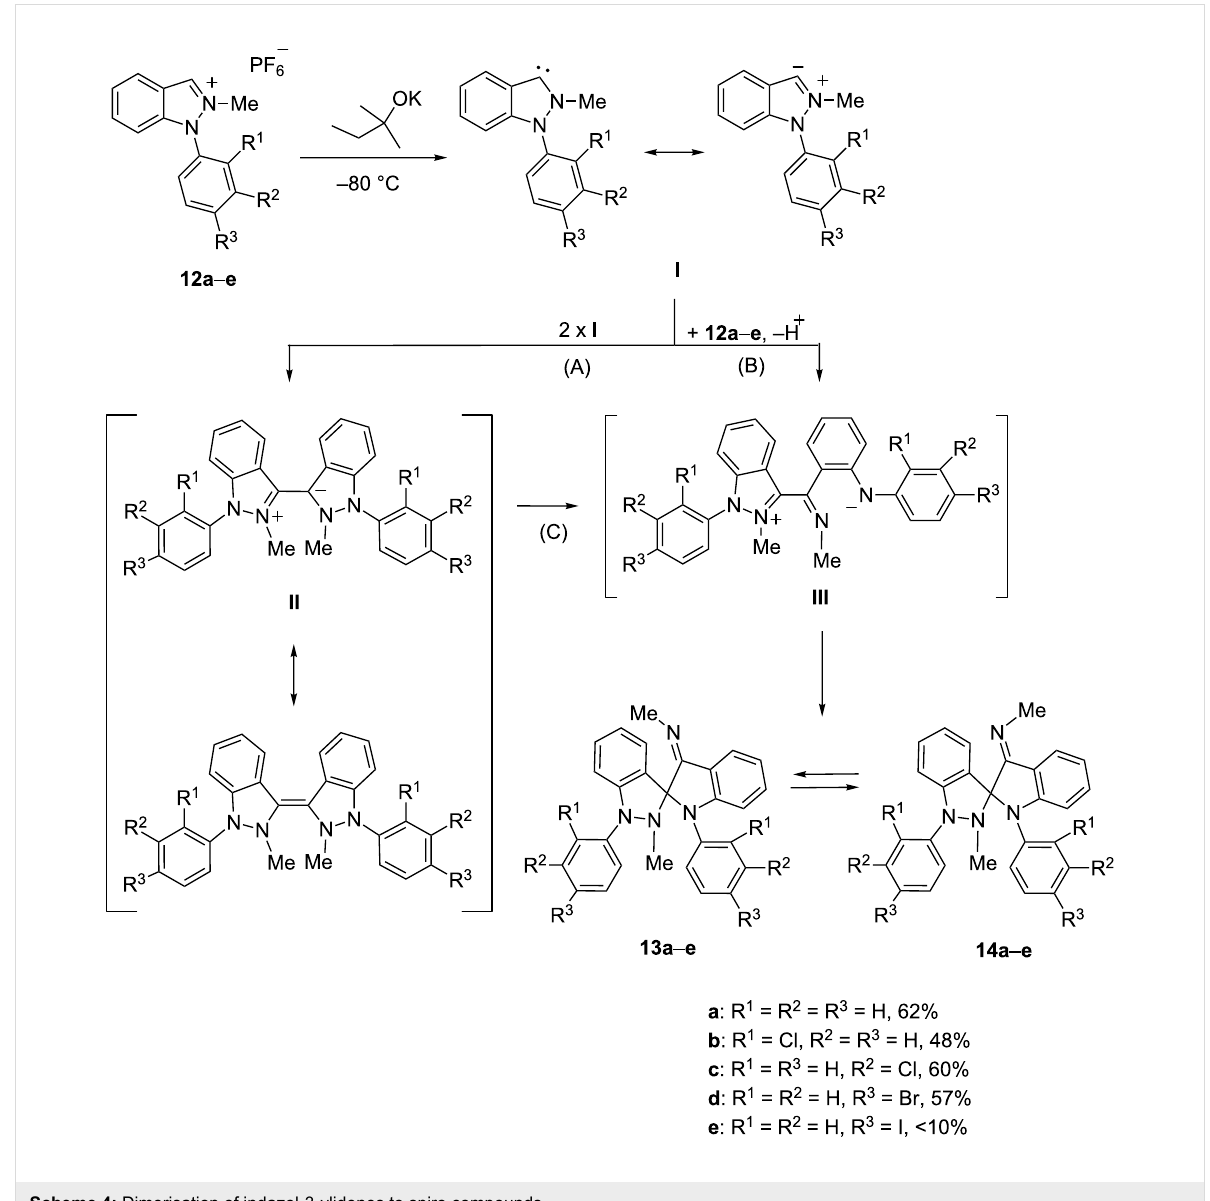
Scheme 4: Dimerisation of indazol-3-ylidenes to spiro compounds.